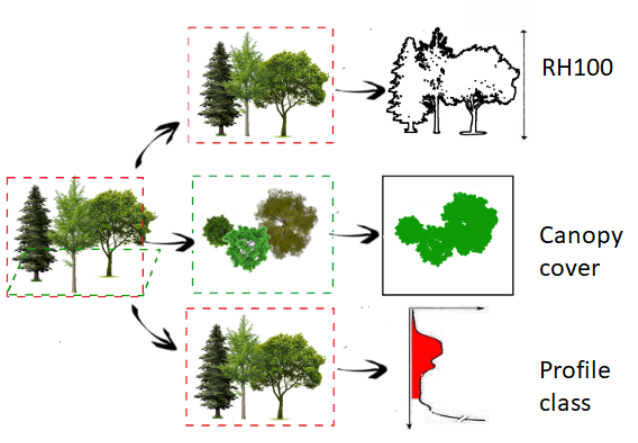
Figure 7. Scheme of the decomposition of the LIDAR waveform in 3